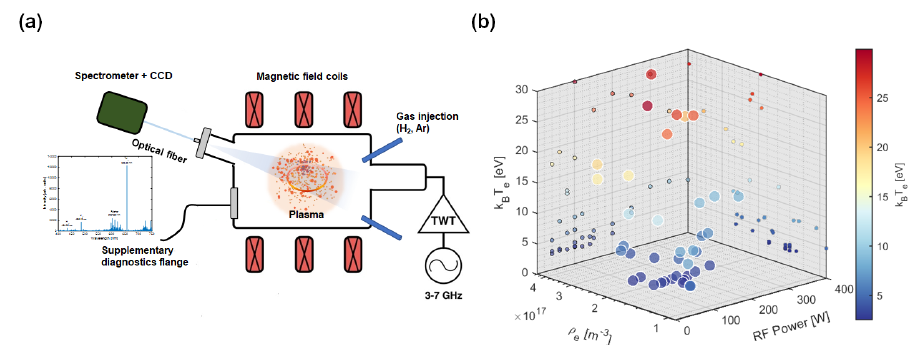
Figure 1. (a) Scheme of the experimental setup - further details in [11]. (b) Plasma electron energy (temperature, k B T e ) [eV] (on z-axis) from OES measurements of H 2 -Ar plasma emission in the FPT at the INFN-LNS. Data are displayed in the electron density ρ e [m − 3 ] - microwave power P RF [W] x y - plane. Projections onto y z -plane ( k B T e vs. ρ e ), and xz -plane ( k B T e vs. P RF ) are also shown. Data were collected for di ff erent experimental configurations in terms of power and gas pressure p g . From projections, plasmas at low k B T e ≤ 3 eV and ρ e ∼ 1 ÷ 2 · 10 17 m − 3 result only from H 2 -Ar plasma, with P RF ≤ 200 W and high-pressure p g ∼ 10 − 2